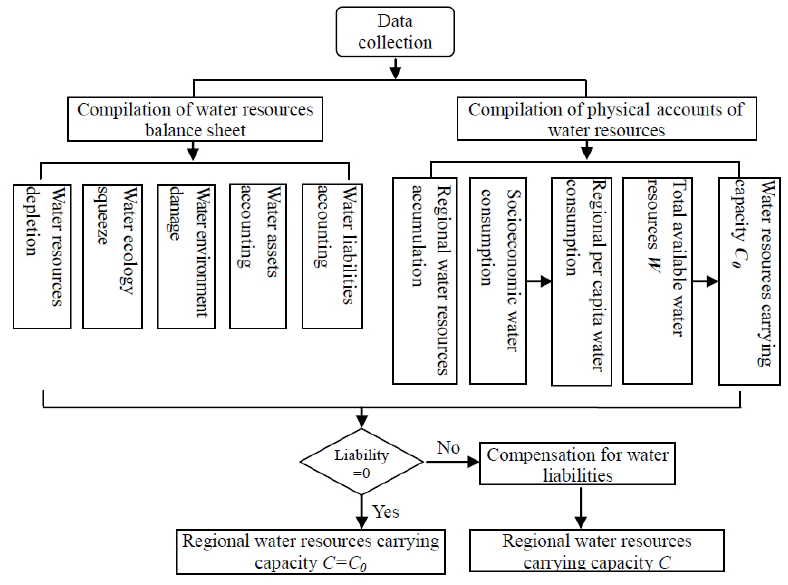
Figure 2. Technical route of carrying capacity quantification.